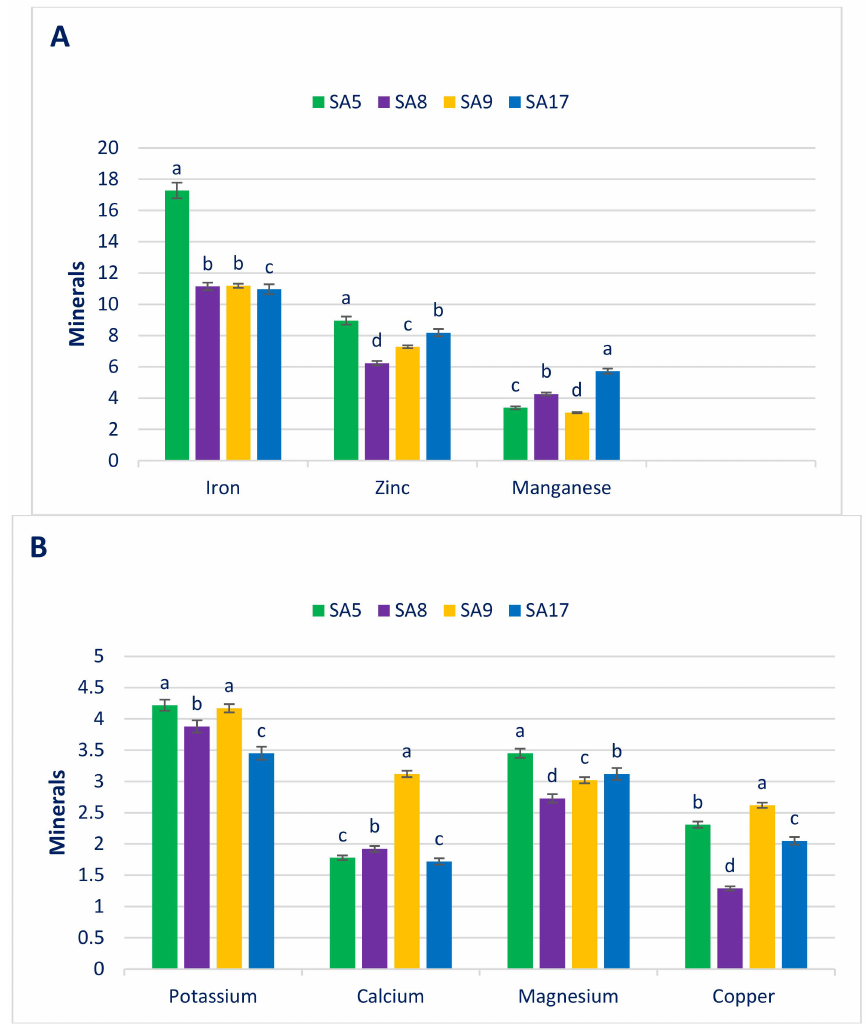
Figure 2. Mineral elements (macroelements mg g − 1 FW, microelements µ g g − 1 FW) in danta leaves. ( A ) Iron, zinc and manganese, ( B ) Potassium, calcium, magnesium, and copper. Dissimilar letters over the bars indicate that the corresponding data significantly differed by DMRT ( p < 0.01, n =